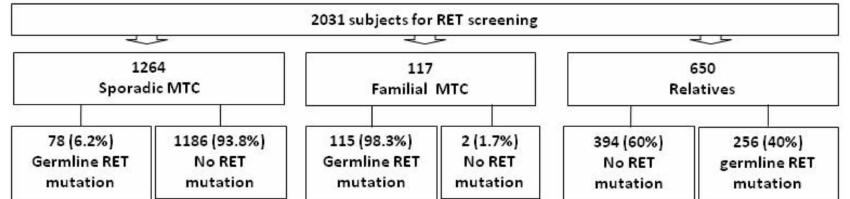
Figure 1. Subjects who underwent RET genetic screening over the last 25 years at our institution: the prevalence of RET mutations according to the first clinical presentations is